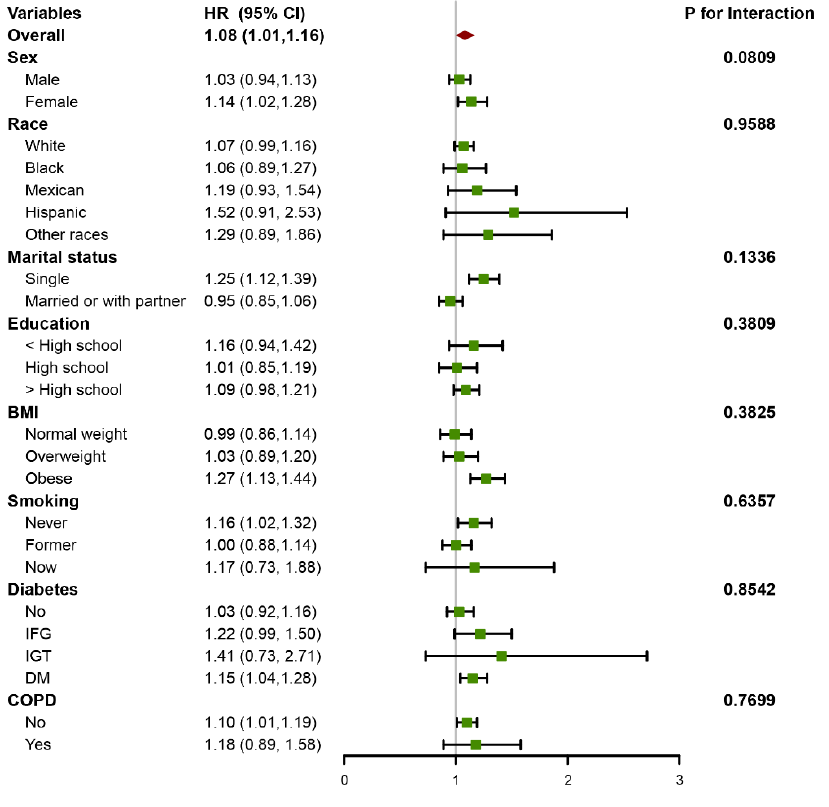
Figure 3. Forest plot for subgroup analysis.